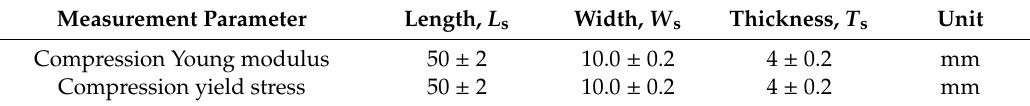
Figure 5. 3D printing process arrangement for X and Z axis printed specimens studied in the experimental test. Table 4. Specimen dimensions for the characterization of GF-PA6 under compression